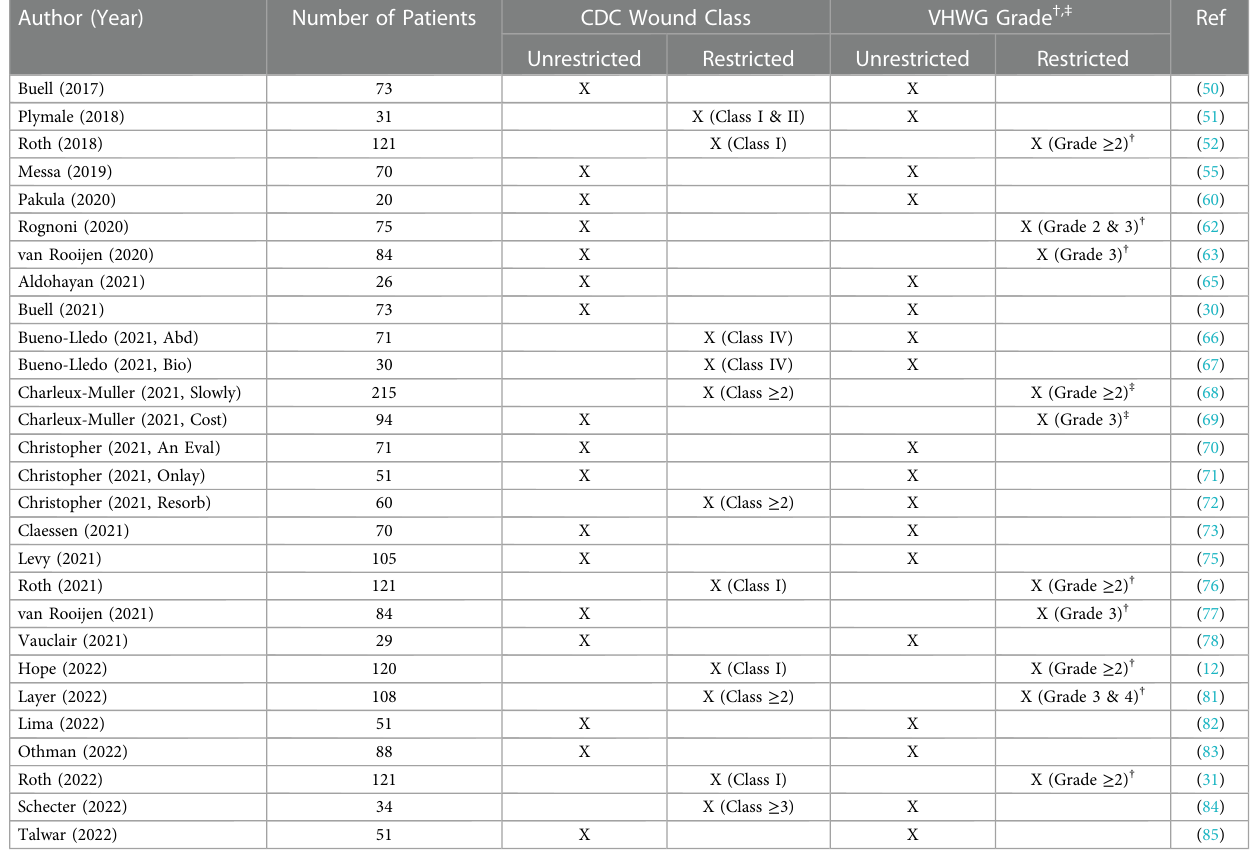
TABLE 4 CDC wound class and ventral hernia working group (VHWG) grade associated with clinical studies involving P4HB mesh in ventral/incisional hernia repair. Author